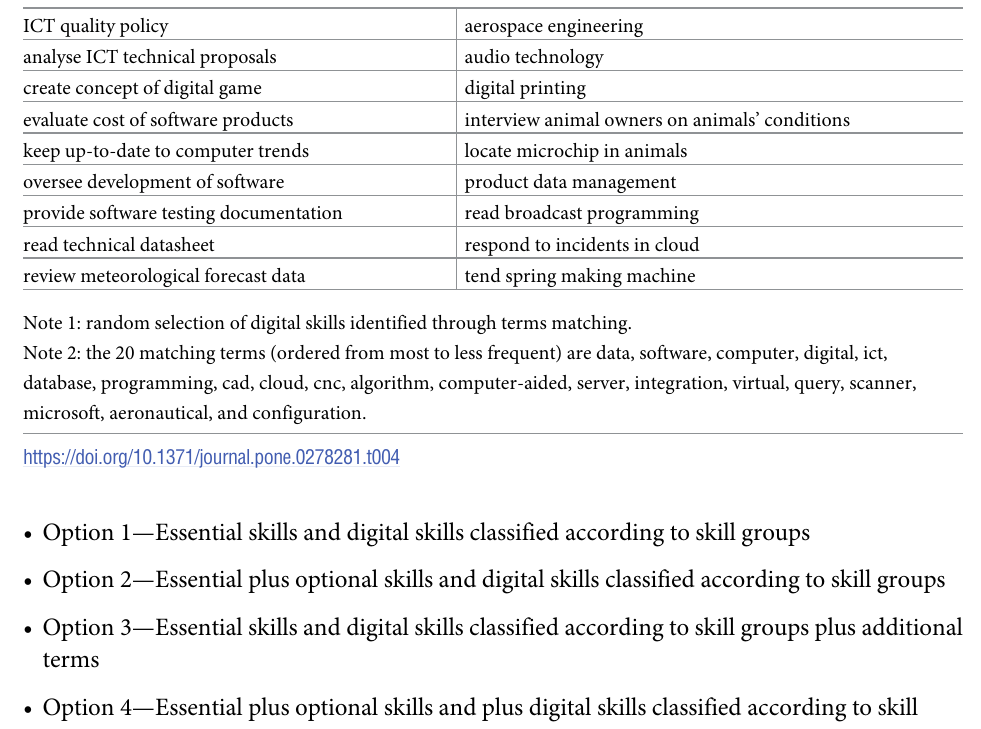
Table 4. Examples of new digital skills through NLP.